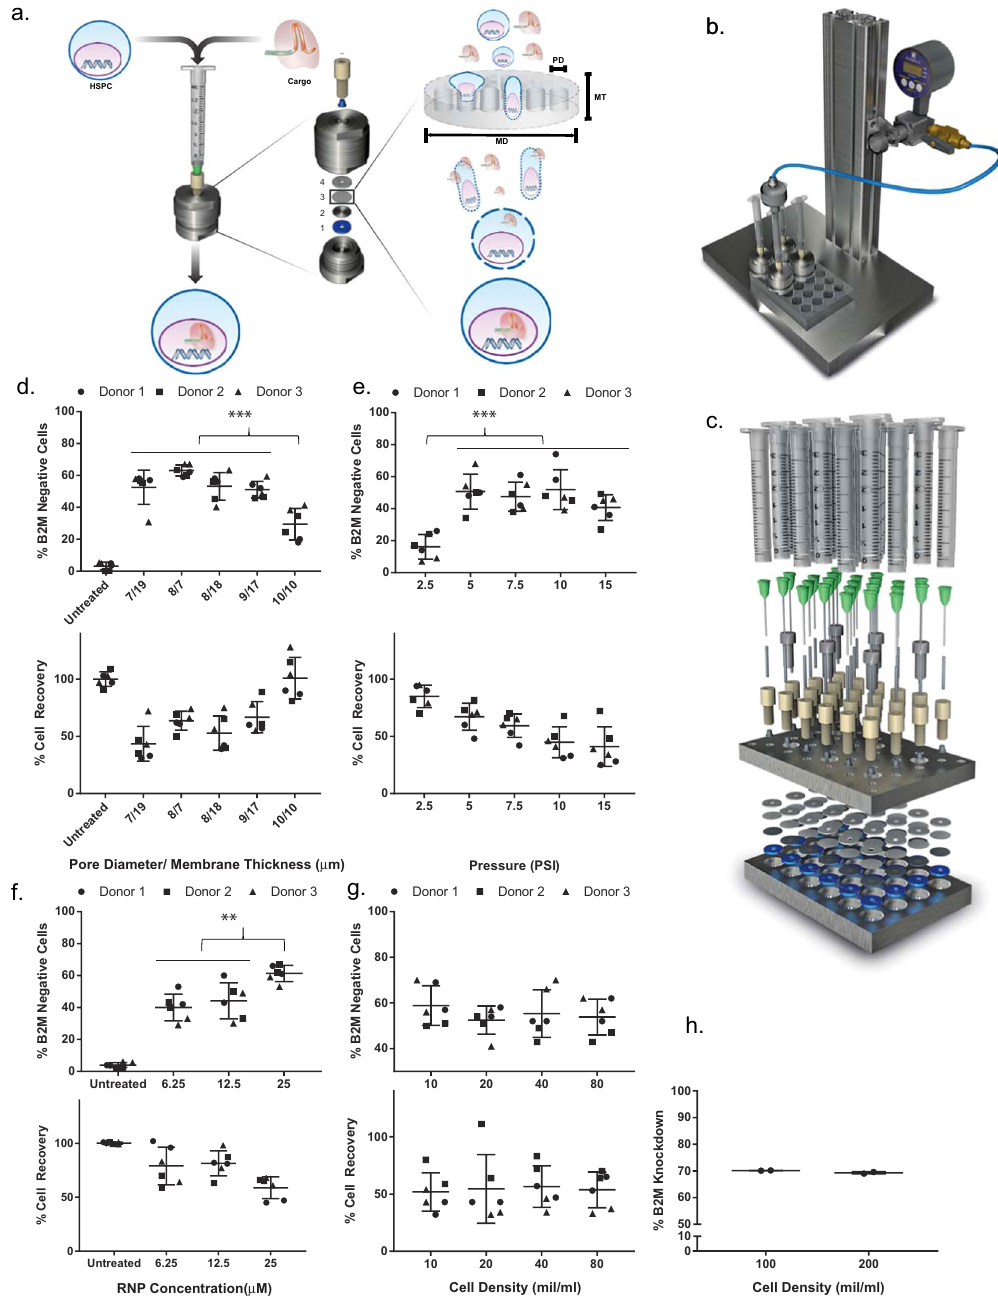
Figure 1. Design and optimization of TRIAMF. ( a ) Schematic illustration of the single unit system. The device consists of a silicone washer (1), a stainless steel mesh (2), a hydrophilic track-etched polycarbonate filter membrane (3), and a PTFE washer (4). MD: membrane diameter; MT: membrane thickness; PD: pore diameter. Not drawn to scale. ( b ) Illustration of basic set up, including the pressure regulator and valve from a nitrogen source, connector, and the membrane holder. ( c ) Illustration of a 24-membranemanifold system. B2M knockout efficiency determined by FACS and cell recovery as a function of ( d ) membrane pore diameter and thickness; ( e ) applied pressure; ( f ) RNP concentration; ( g ) cell density (n = 6, 3 donors with duplicate of each donor). When not specified, the sample volume was kept at 50 μ l, cell density at 8 × 10 7 cells/ml, nitrogen pressure at 5 PSI and 7 μ m thick membranes with 8 μ m pore diameter were used. ( h ) B2M knockout efficiency remained the same with further increased cell density from 10 8 to 2 × 10 8 cells/ml in 50 μ l volume processed by TRIAMF using 25 μ M of RNP, 7 μ m thick membrane with 8 μ m pore diameter under 5 PSI nitrogen pressure (n = 2). *** p < 0.001, ** p < 0.002, one-way analysis of variance (ANOVA) and Tukey’s multiple comparison test. Bars represent standard deviation. Alan Abrams helped to produce the graphics in ( a – c